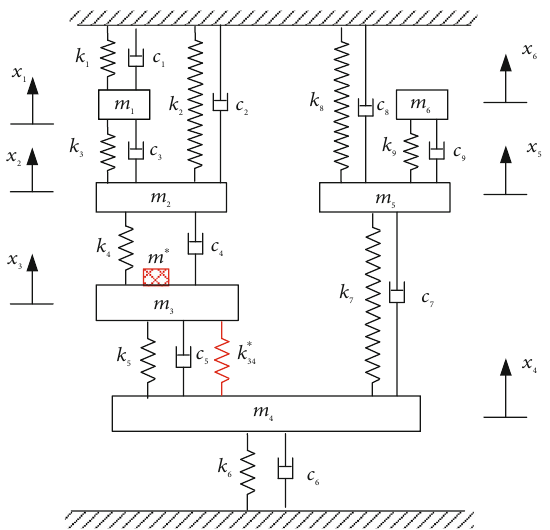
Figure 3: Six-DoFs damped mass-spring system with added mass and spring. Table 1: Natural frequencies of the original system and the modi fi ed system.